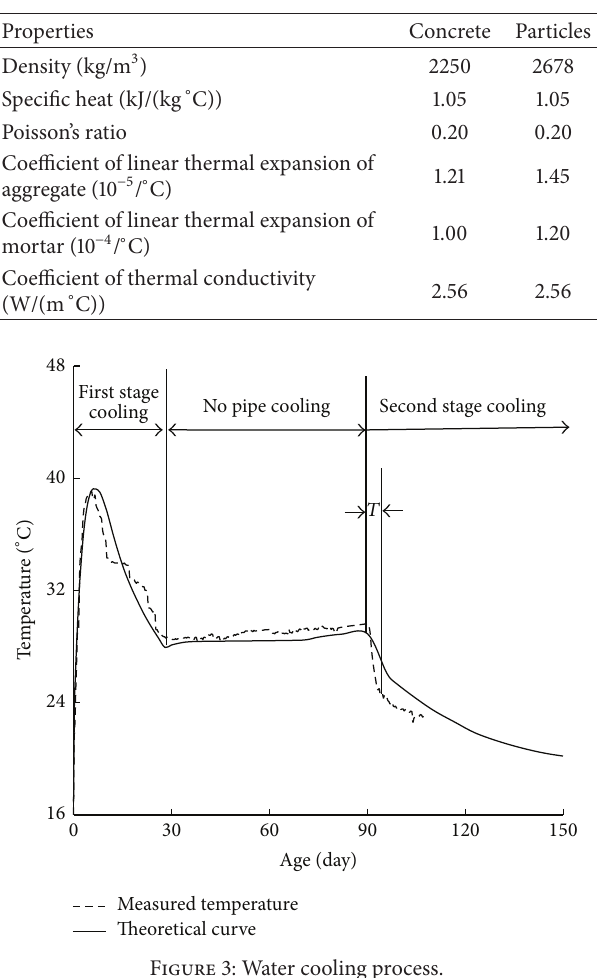
Table 1: Thermal properties.